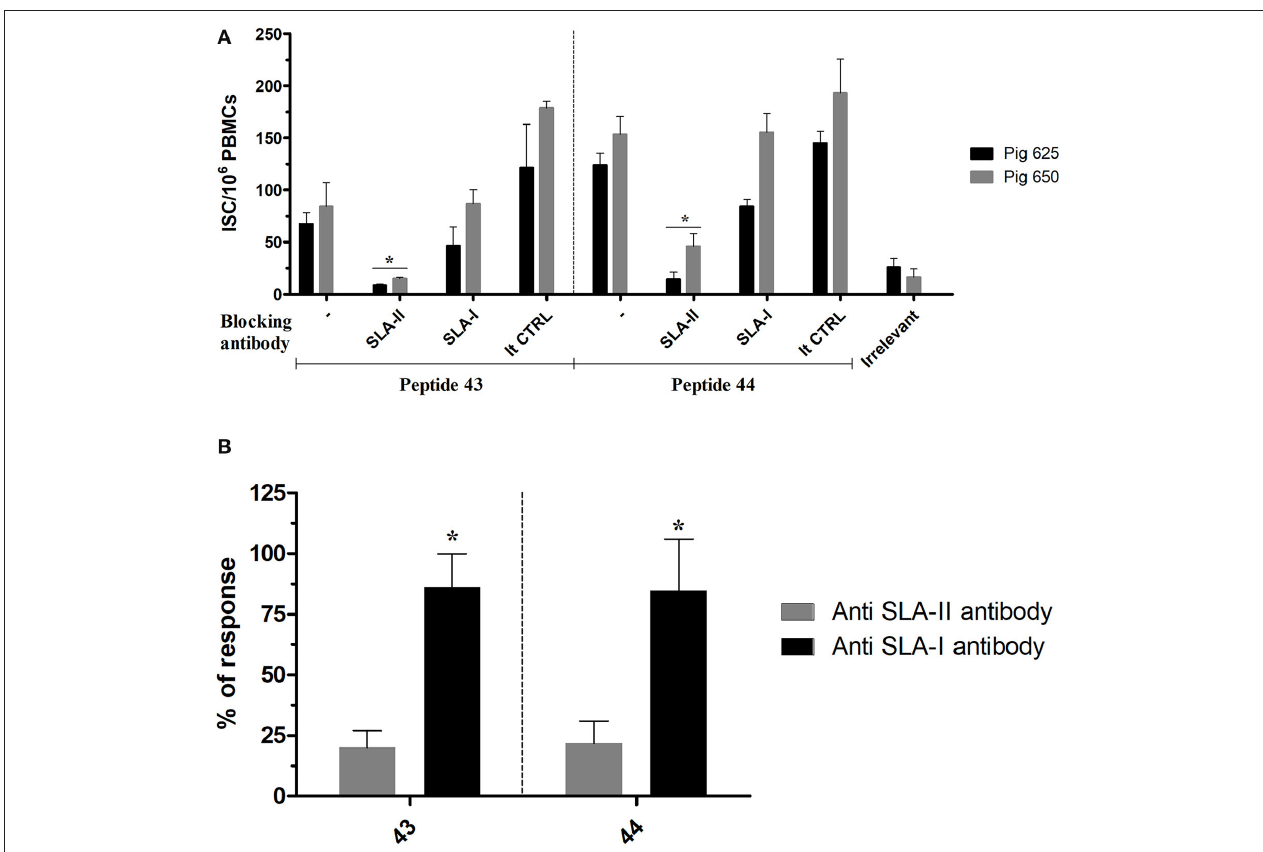
FIGURE 2 | SLA class restriction of the identified immunogenic regions. The peptides 43 and 44 were used to recall ex-vivo an immune response in PBMC collected from pigs immunized with IAV (cohort 3) in presence of SLA-II and SLA-I specific antibodies. The response was then quantified by IFN γ ELISPOT and calculated as ISC/10 6 PBMCs. The irrelevant peptide was used to evaluate the specificity of the peptide induced response. The isotype control antibodies were used to check the specificity of the restriction of the anti SLA antibodies. (A) The response of each tested pigs was represented as mean with sd; the asterisks indicate a statistically significant difference (Wilcoxon signed-rank test; n = 3; p < 0.05). (B) Percentage of the ISC/10 6 PBMCs recalled in presence of anti SLA-antibodies compared to their absence. The asterisk indicates a statistically significant difference (Wilcoxon signed-rank test; inter assay n = 4; p <